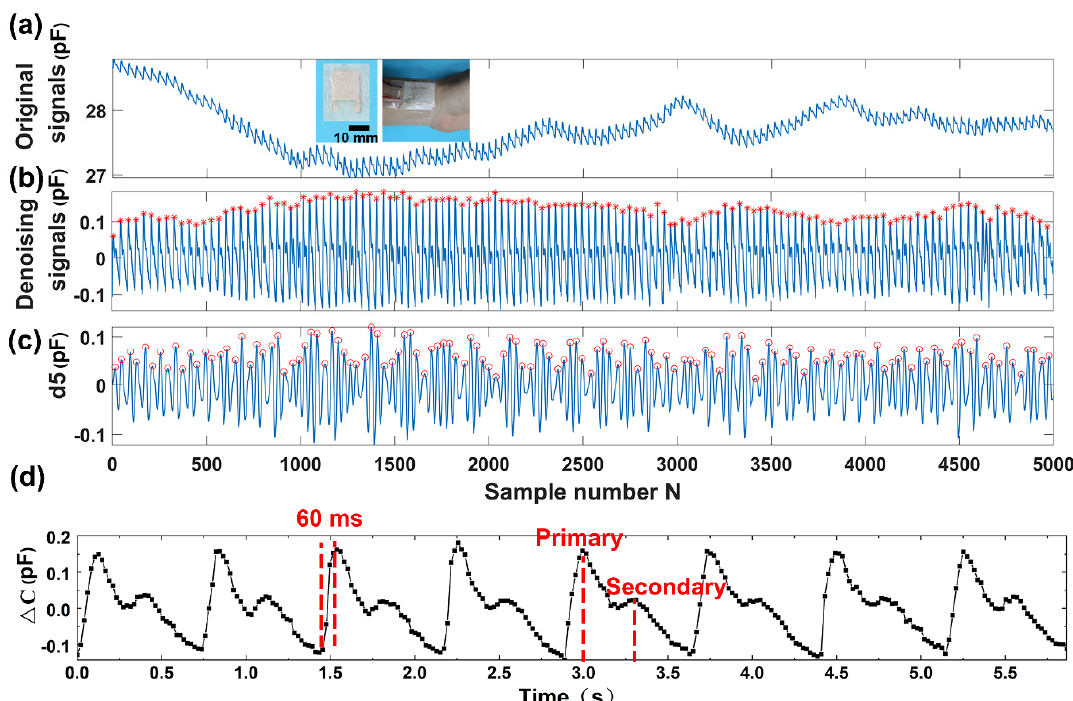
Figure 5. Detection and analysis of wrist pulse acquired by the capacitive sensor. ( a ) The recorded wrist pulse. ( b ) The wrist pulse after denoising and drift removal. ( c ) The 5th level wavelet high-frequency coefficient decomposed from the recorded wrist pulse signal (d5). ( d ) The enlarged denoising wrist pulse.